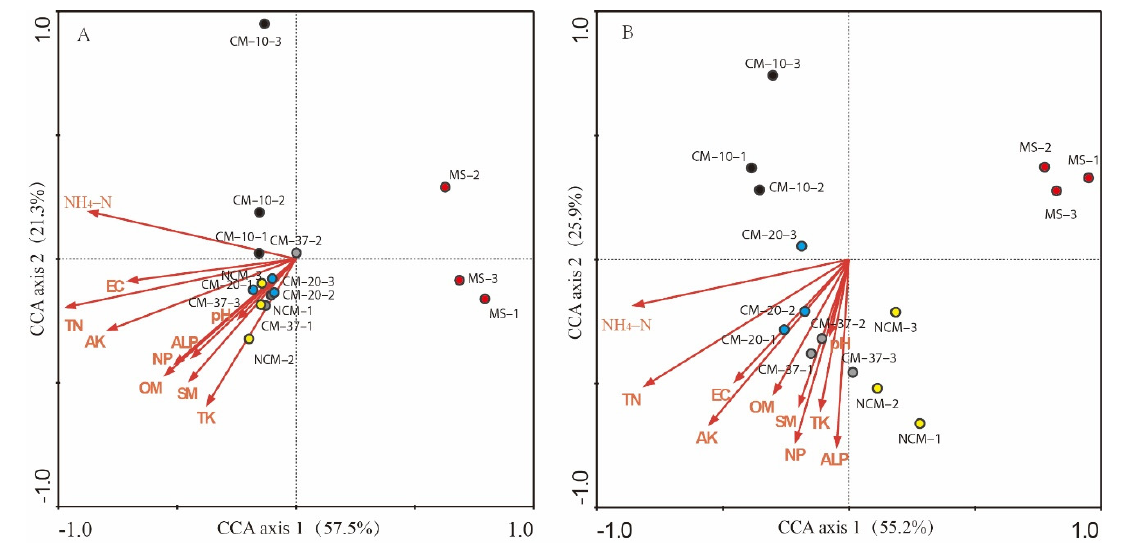
Figure 7. Canonical correspondence analysis (CCA) of soil properties driving phoD and gcd microbial composition. ( A ) phoD community; ( B ) gcd community. MS: moving sand dune; CM10: 10-year-old Caragana microphylla plantation; CM20: 20-year-old C. microphylla plantation; CM37: 37-year-old C. microphylla plantation; NCM: Natural C. microphylla community. OM: Organic matter; TN: Total N; ALP: alkaline phosphomonoesterase; NP: NaHCO 3 -Pi; TK: total K; AK: available K; EC: electrical conductivity; SM: soil